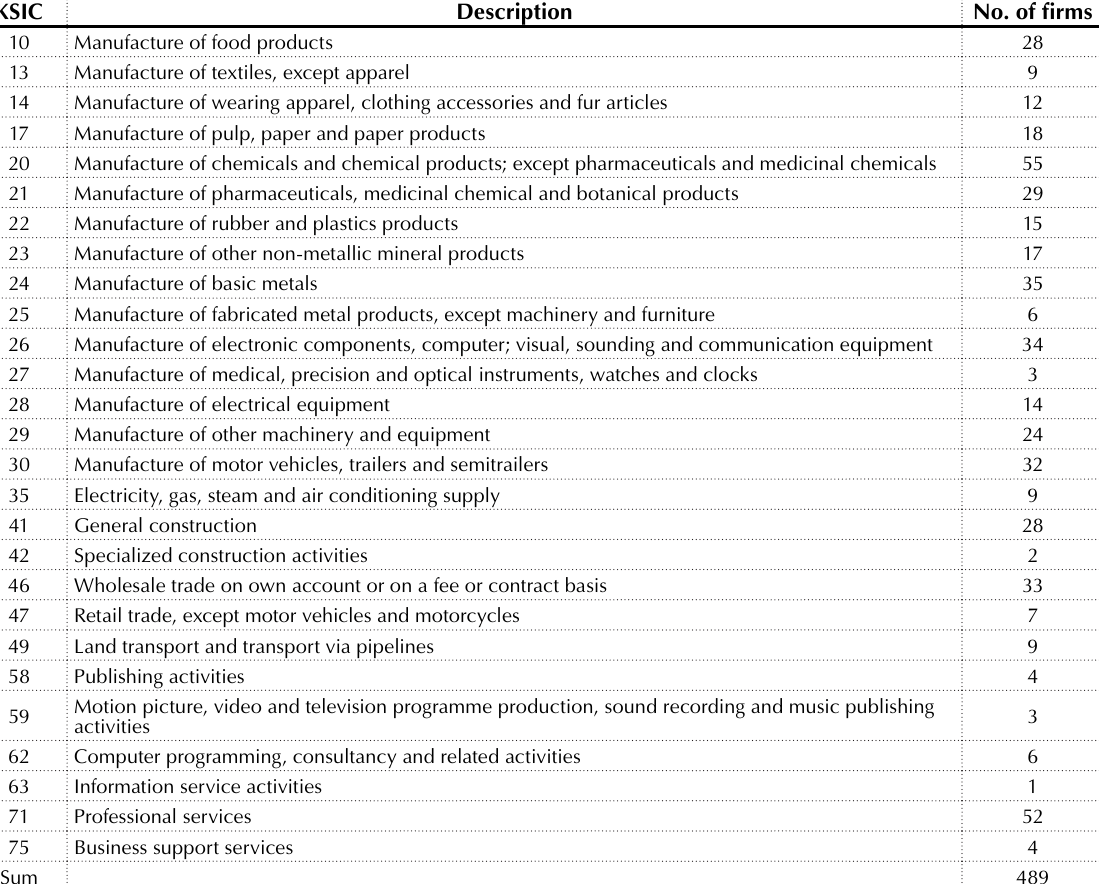
Table 1. Sample firms’ industry